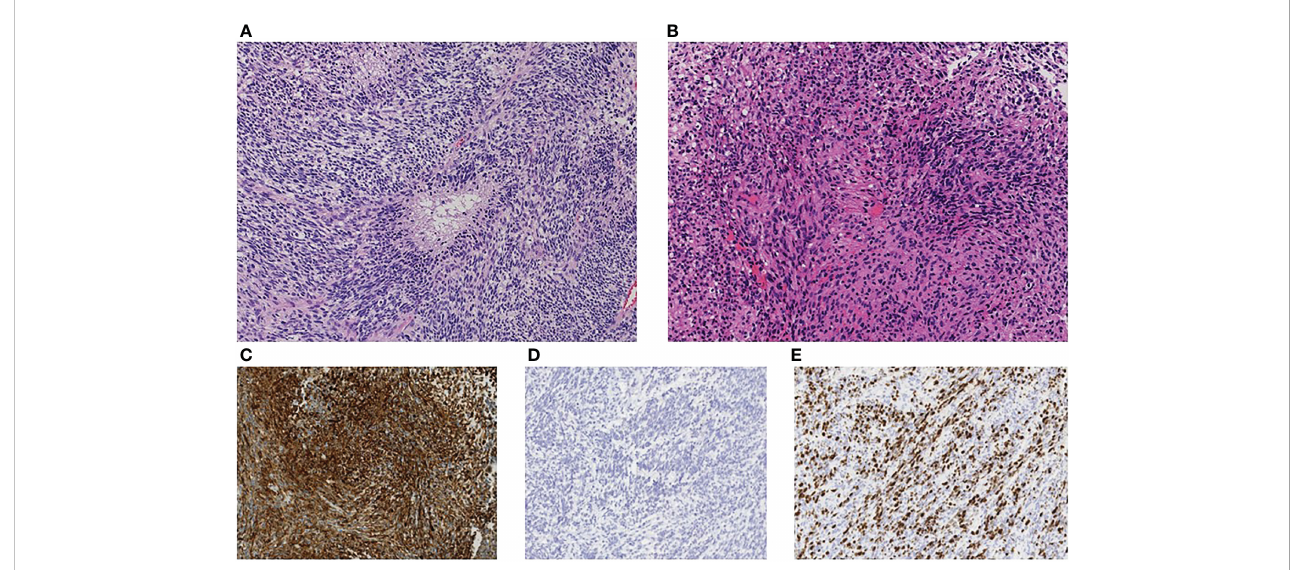
FIGURE 3 Immunohistopathological investigation showed densely in fi ltrating spindle-shaped cells with eosinophilic cytoplasm accompanied with regions of necrosis, consistent with glioblastoma (A) primary site, (B) lumbar metastasis). The cells were positive for glial fi brillary acidic protein (GFAP) (C) and negative for mutant isocitrate dehydrogenase 1 (IDH1-R132H) (D) . MIB-1 labeling index was 30% (E) . The original magni fi cation was x200 (A – E)